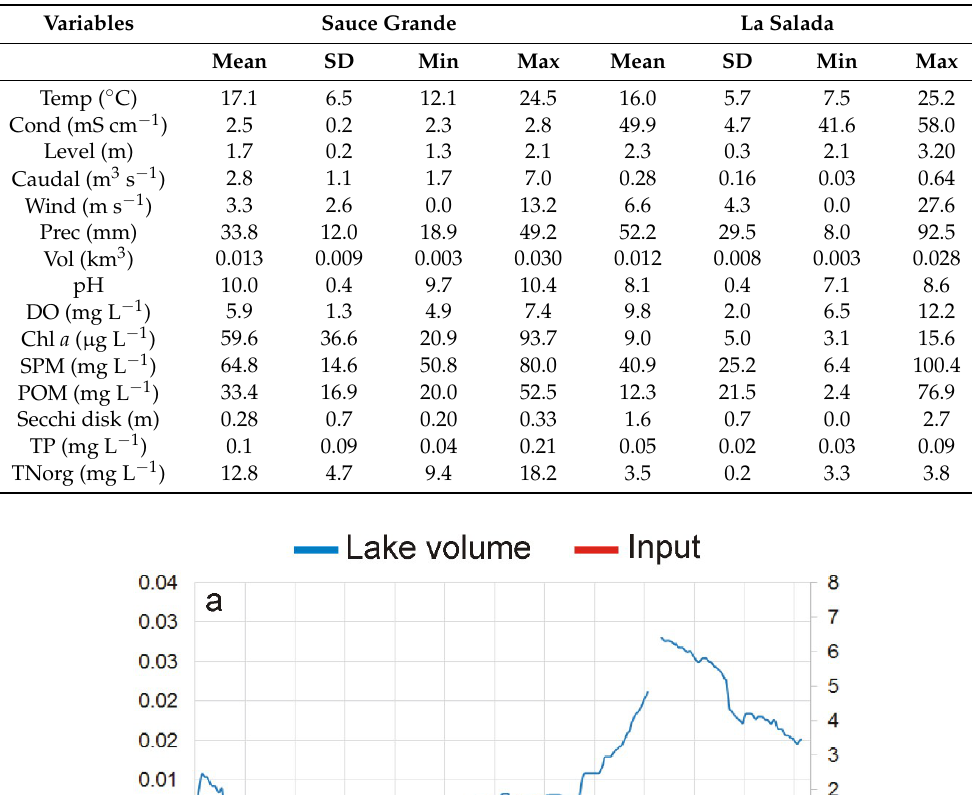
Table 2. Mean, standard deviation (SD), minimum (Min), and maximum (Max) values of the environmental parameters measured in La Salada and Sauce Grande Lakes during the study period.